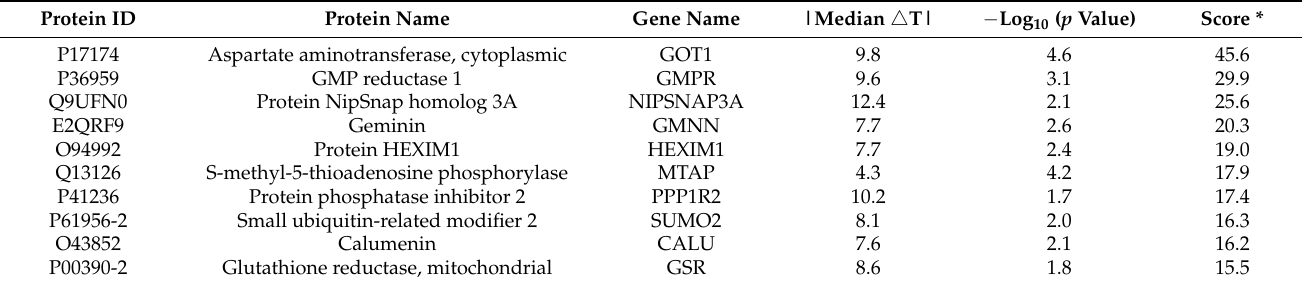
Table 1. Top 10 protein candidates interacting with isoAsp in a